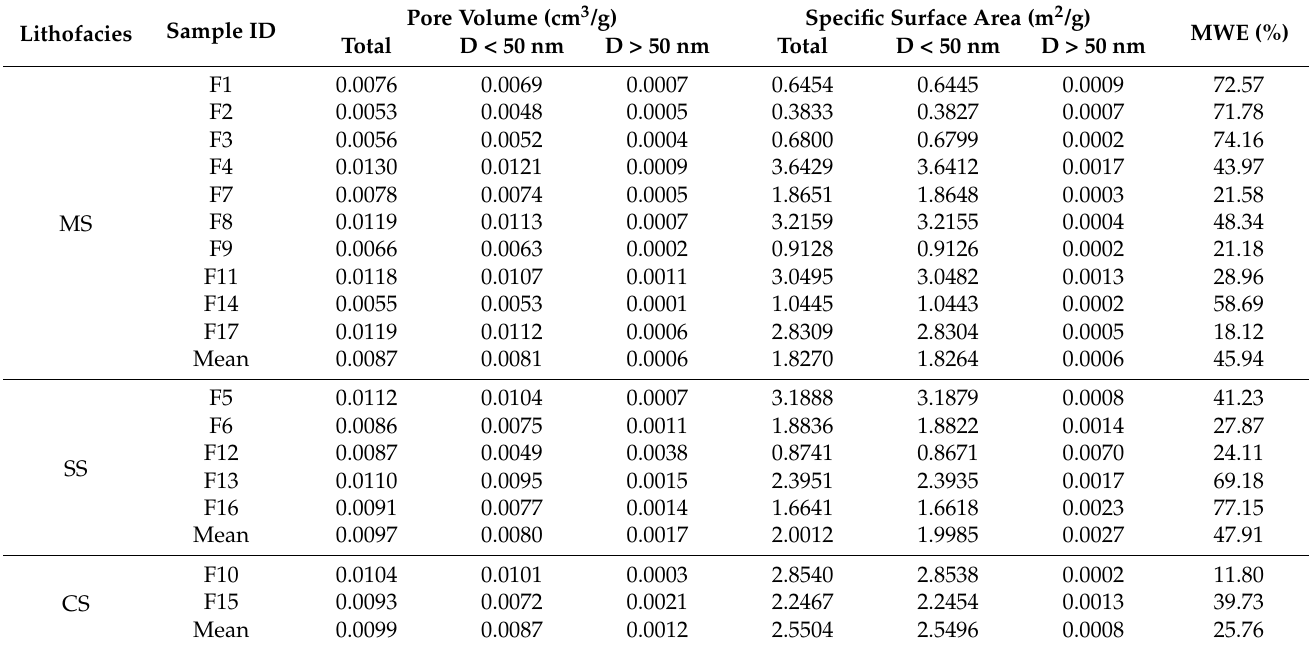
Figure 5. MIP of the Funing Formation shale samples. MWE: mercury withdrawal efficiency. ( a ) MS lithofacies; ( b ) SS lithofacies; ( c ) CS lithofacies. Table 2. Pore structure parameters of different